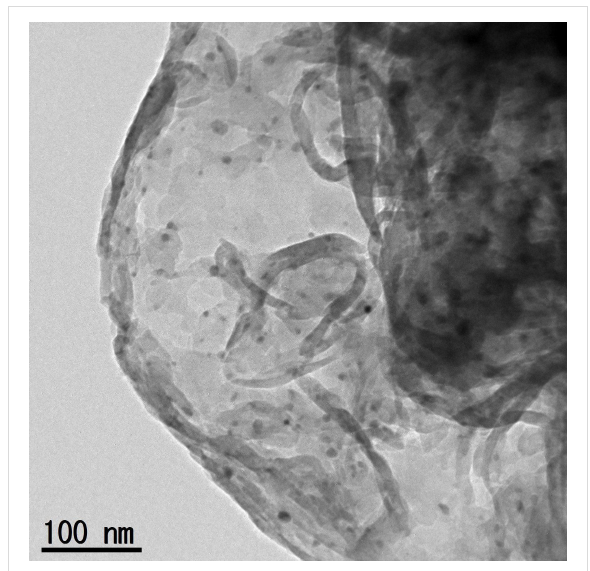
Figure 5: A typical TEM image of Ag-loaded g-C 3 N 4 . The synthesis temperature of g-C 3 N 4 was 873 K in this